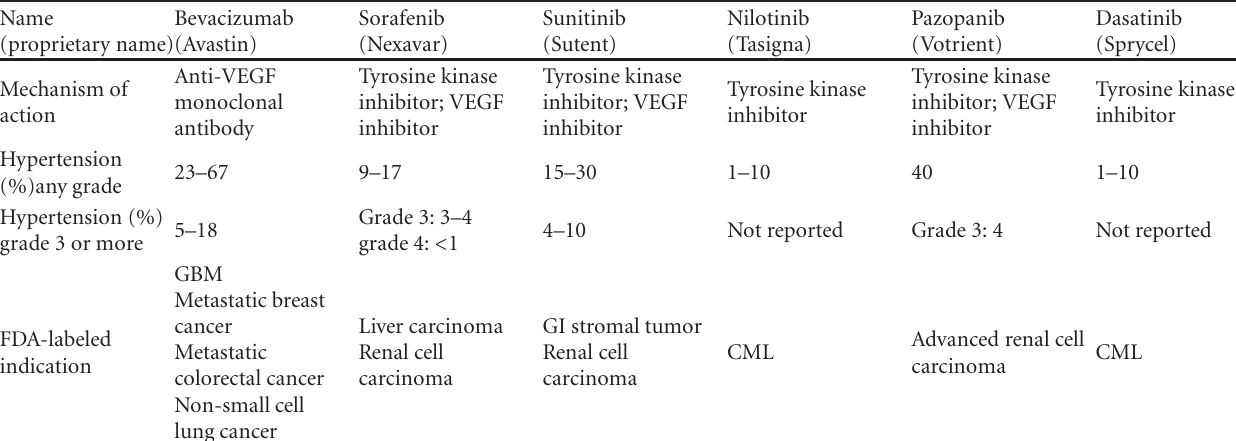
Table 1: Current VEGF kinase inhibitors in use in the United States